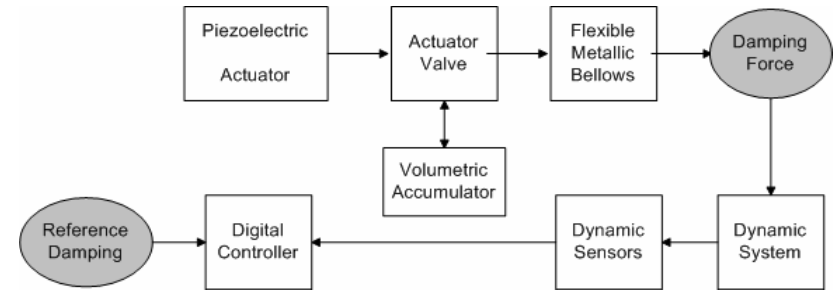
Fig. 1. Block Diagram of the proposed active